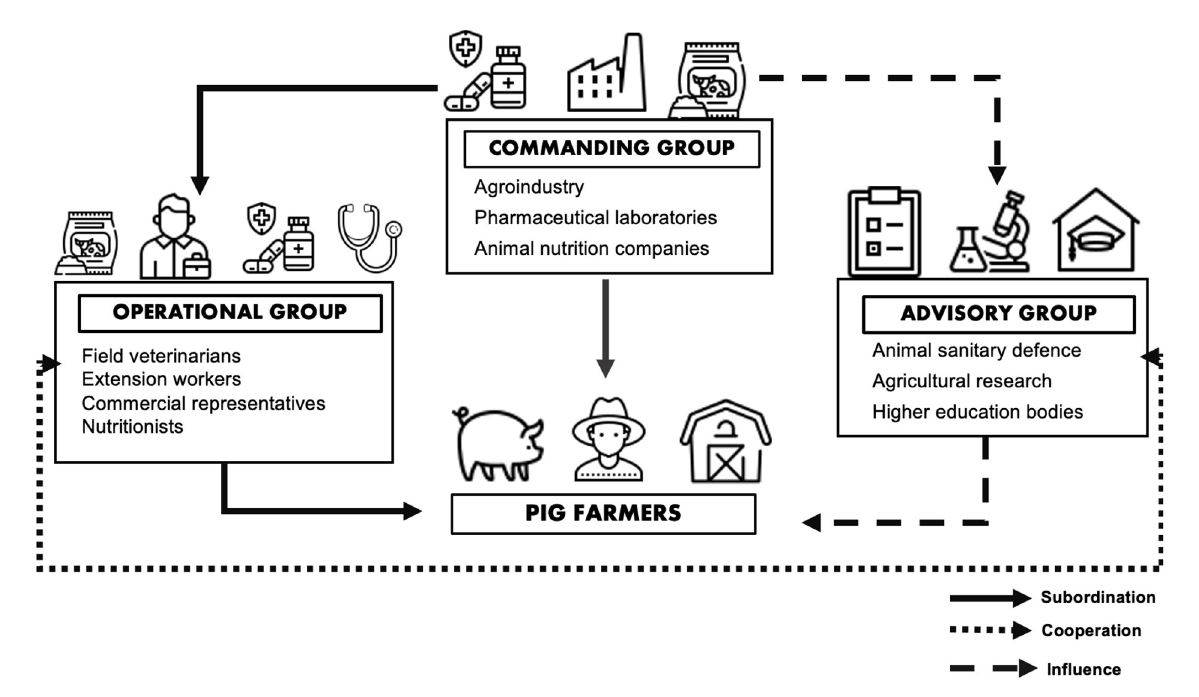
FIGURE1 Description of the groups that make up the social pillar and their relationships.